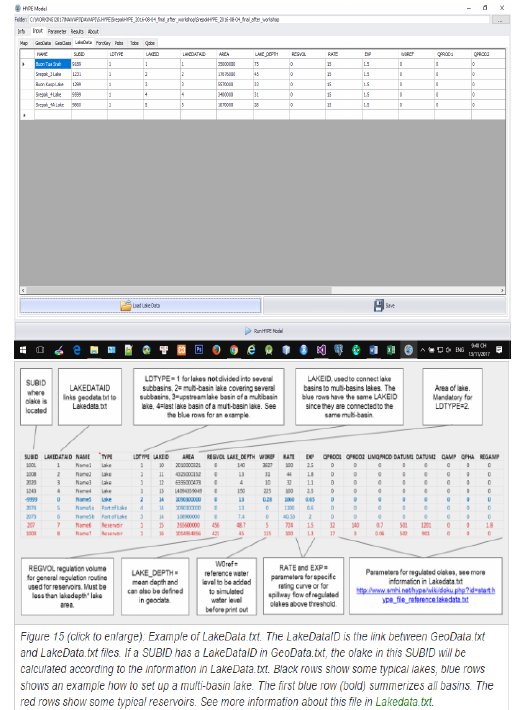
Fig. 7: Function of management of lake data on V- HYPE